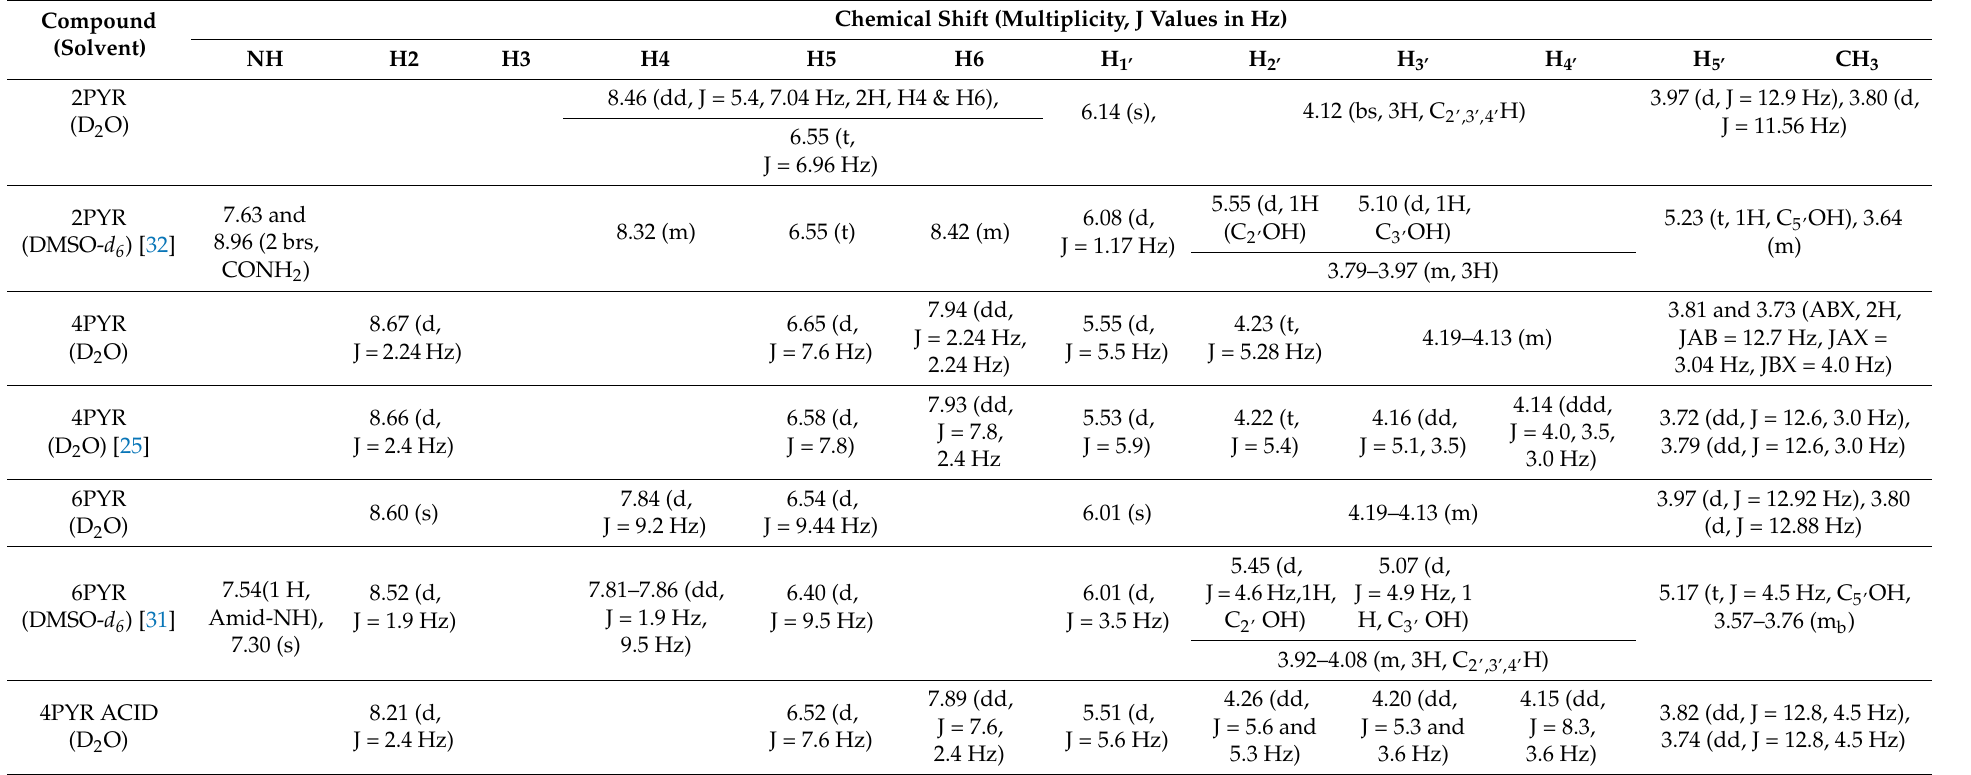
Table 3. Tables of 1 H NMR chemical shift for the ribosylated